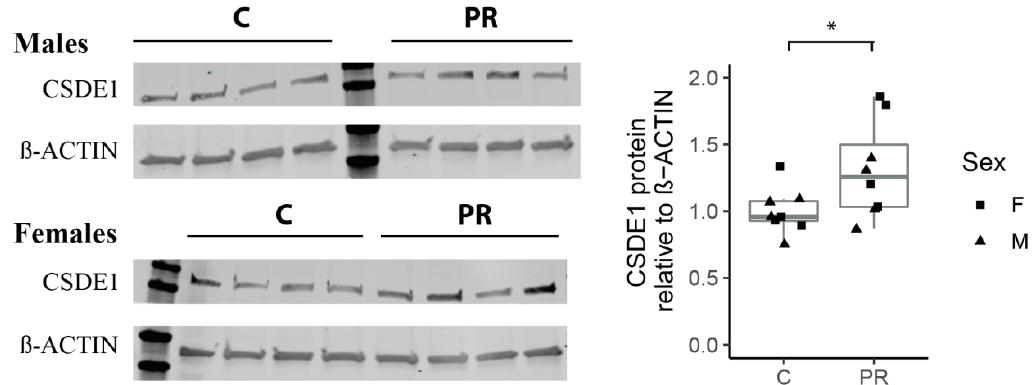
Figure 6. Quantification of the CSDE1 protein in E17 fetal Hypothalamus using Western blot. (PR: n = four males + four females, C: n = four males + four females) (ANOVA, group effect * p = 0.04, sex- effet p = 0.18) (boxplot: median, first and third quartiles).